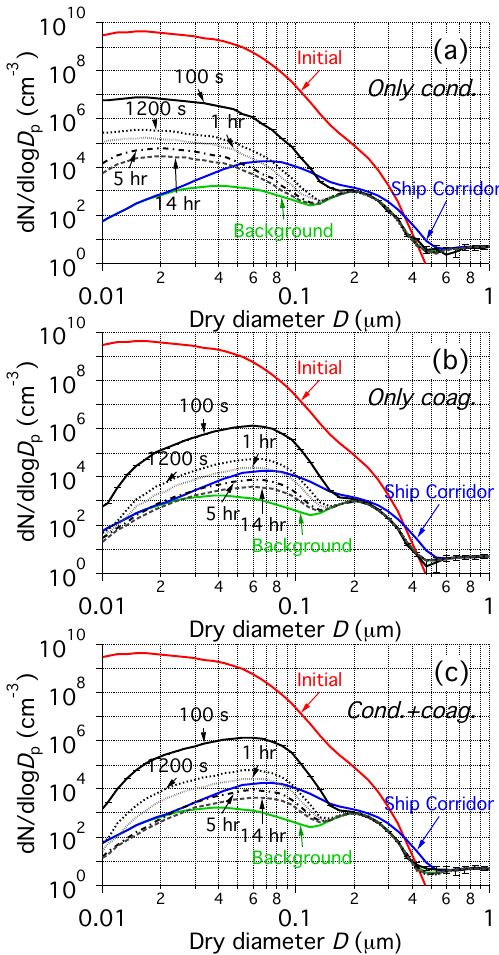
Figure 4. Measured aerosol number distributions for background, initial and ship corridor and modeled results for (a) neglecting co- agulation, (b) neglecting condensation and (c) including condensa- tion and coagulation at plume ages of 100s, 1200s, 1h, 5h, and 14h for base case (starting from 14:00LT). The error bars represent 95% confidence intervals from 10 ensemble runs (only shown for size distribution at 100s as an